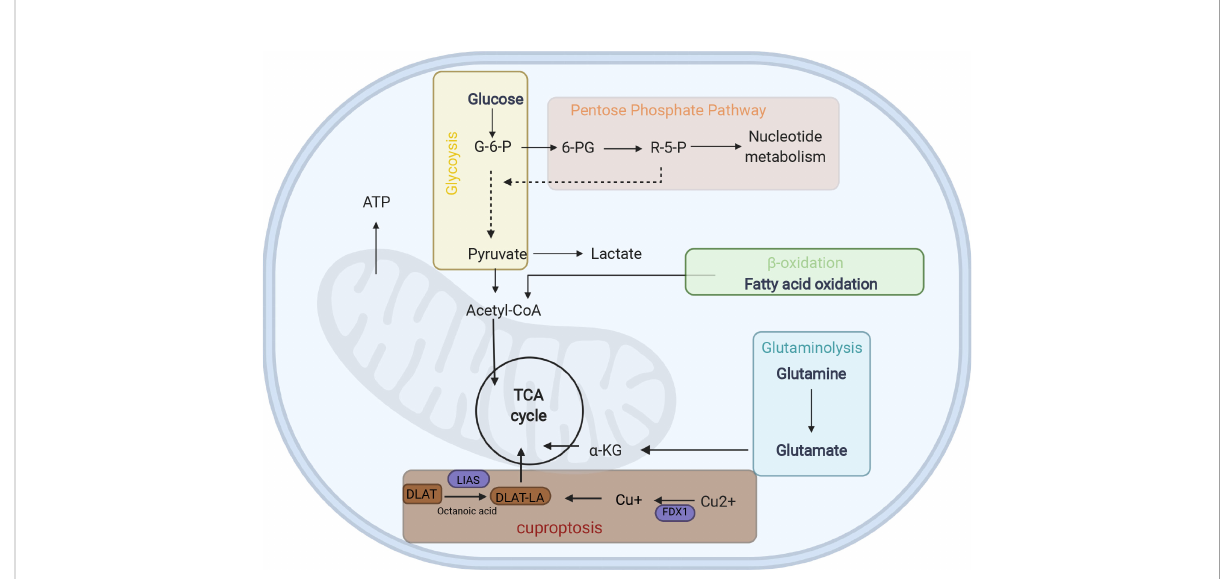
FIGURE 5 Energy metabolism diagram. G6P glucose-6- phosphate, 6-PG Glucose 6-phosphate, R-5-P ribose-5-phosphate, a -KG a -ketoglutarate, LA lipoylation, DLAT, a protein target of